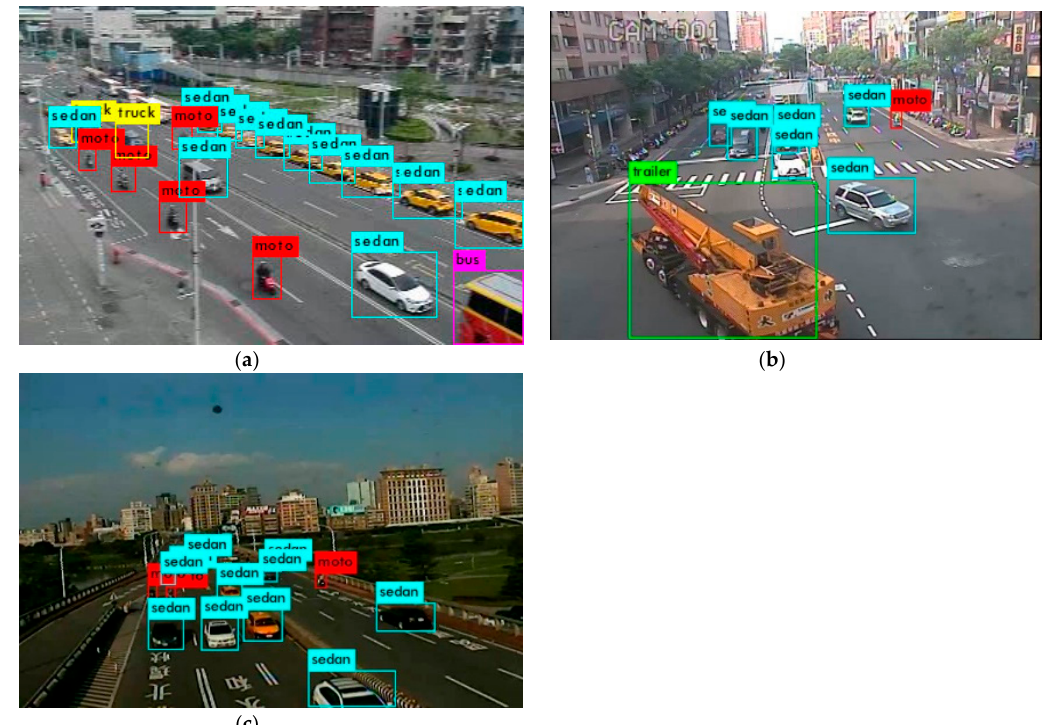
Figure 2. Detection results on ( a ) the road, ( b ) the crossroad, and ( c ) the bridge. Each vehicle is positioned by a colored bounding box. Different colors denote different categories. Purple, yellow, cyan, red, and green represent bus, truck, sedan, motorcycle, and trailer, respectively.